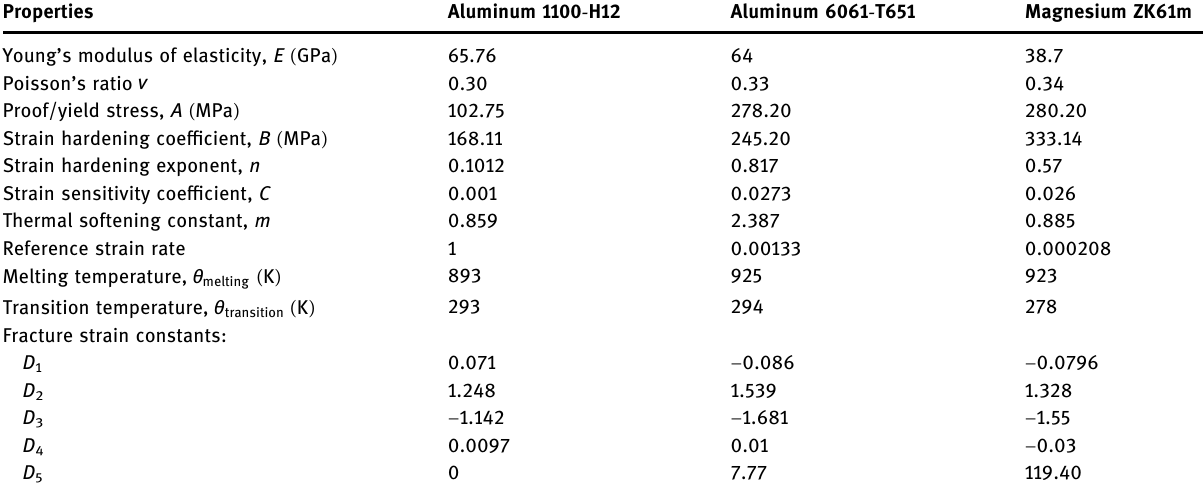
Table 3: Material properties of aluminum 1100 - H12, aluminum 6061 - T651, and magnesium ZK61m [ 16,17,30 ]